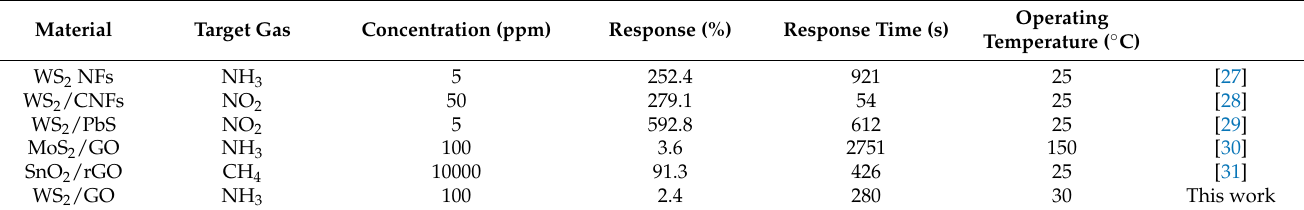
Table 1. Gas sensitivity of various types of two-dimensional